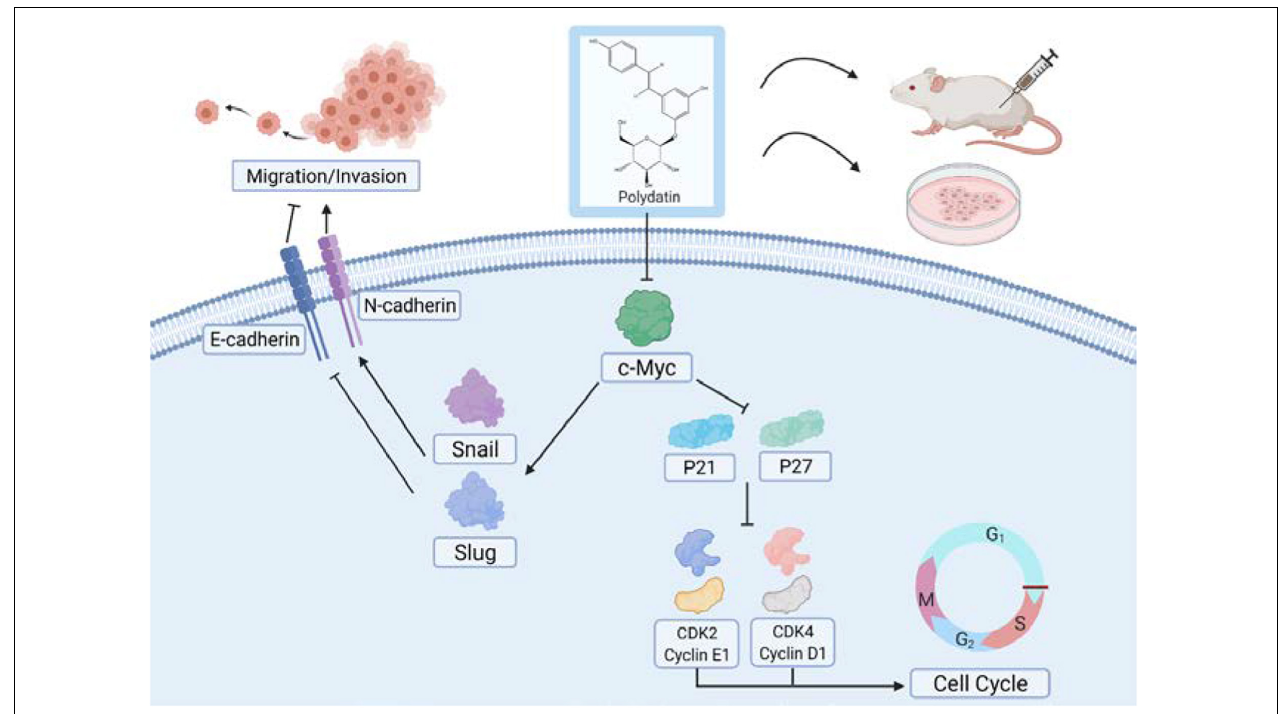
FIGURE 8 | Model for polydatin inhibition of cell proliferation and metastasis of human cervical